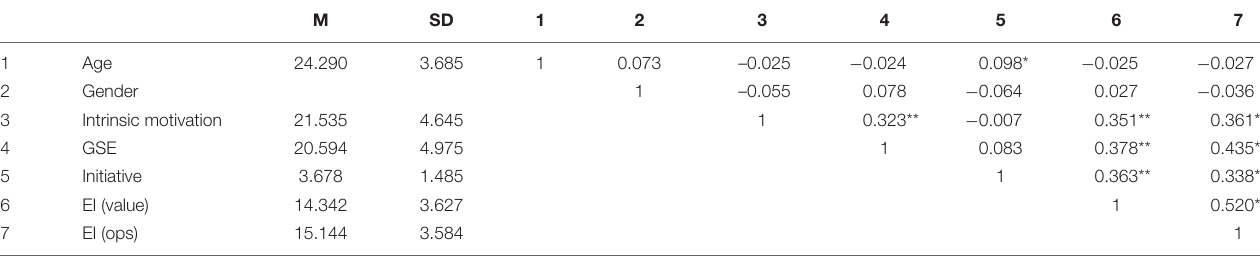
TABLE 2 | Descriptive statistics and correlation matrix.